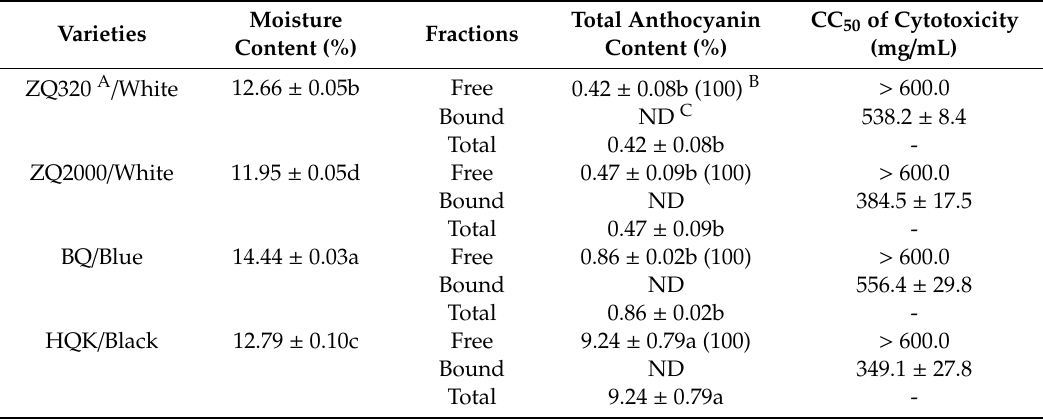
Table 1. Moisture and total anthocyanin contents, and median cytotoxic concentration (CC 50 ) of cytotoxicity in four highland barley varieties (mean ± SD, n =